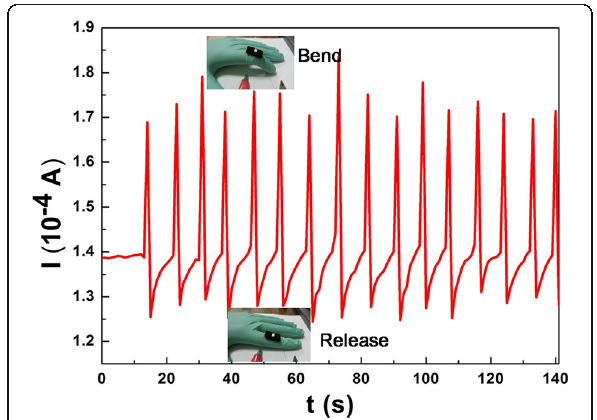
Fig. 11 NH 3 sensing properties of the PANI/sponge composite under different